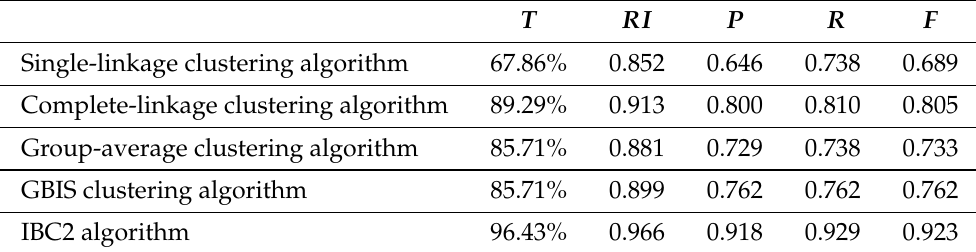
Figure 3. Comparing clustering results, when the number of clusters is given beforehand, using RealWorld data set. Table 9. Comparing evaluation parameters using RealWorld data